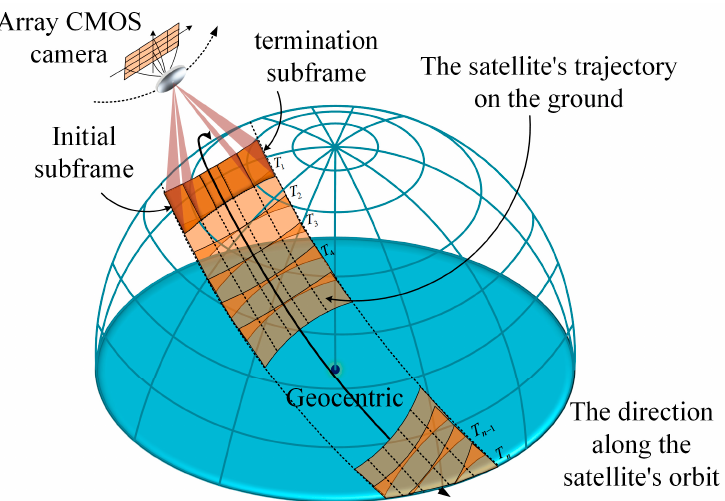
Figure 1. Schematic diagram of dynamic frame-by-frame imaging.